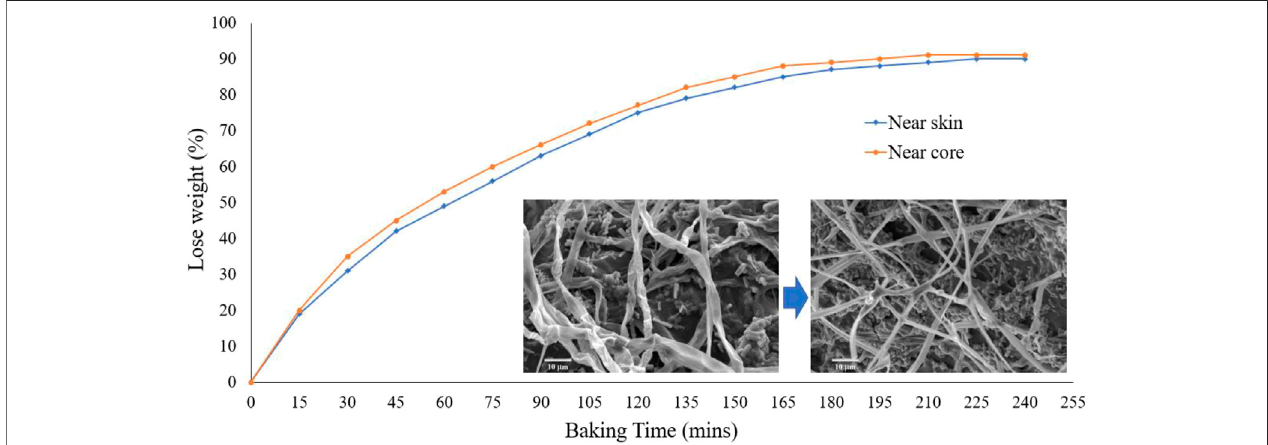
FIGURE 3 | The amount of water loss percentage compared to the original weight. Inserted fi gure (left) : the natural mycelium fi ber from the skin of king oyster mushroom. Inserted fi gure (right) : baked 30 min of mycelium fi ber from the skin of a king oyster mushroom. It is shown that the natural fi bers represent tubes with naturally bent overall conformation. In contrast, the dry ones become a fl at ribbon curved up in the radial direction with a straight overall conformation, suggesting the more signi fi cant bending stiffness of the fi ber.